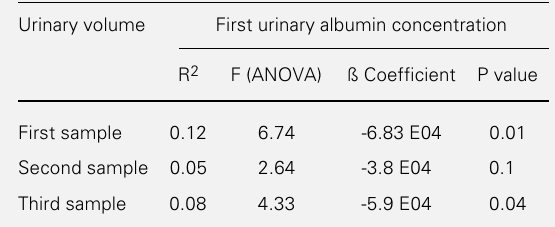
Table 2 - Univariate regression analysis of first morning urinary albumin concentration with first morning urine volume of 50 IDDM